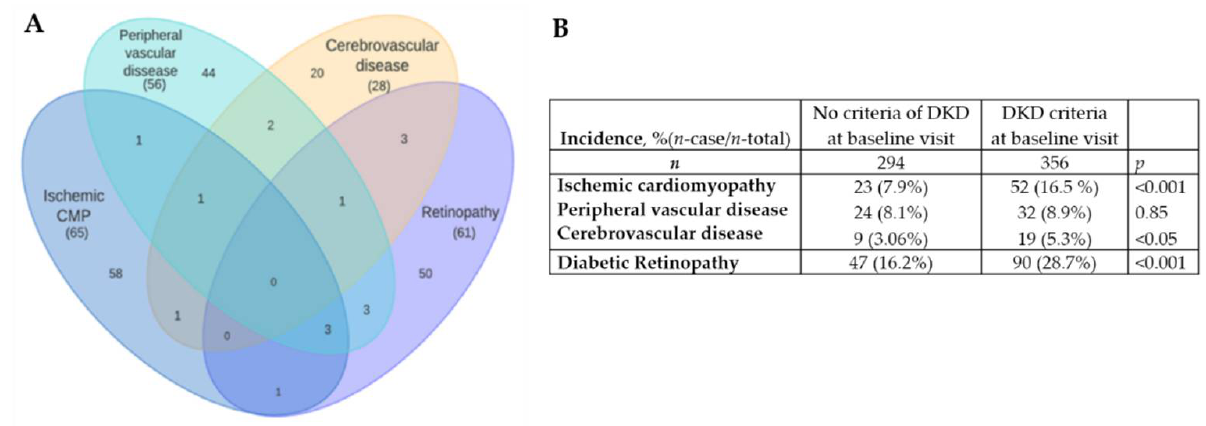
Figure 3. ( A ) Schematic distribution of the recorded cardiovascular events and new onset of diabetic retinopathy, throughout the follow-up period; ( B ) Incidence of the recorded cardiovascular events and diabetic retinopathy during the follow-up, by criteria of DKD at baseline visit. There was overall mortality of 23%—38% of which was due to cardiovascular causes, and 16% due to cancer. Furthermore, throughout the follow-up, 22 patients (3.6%)